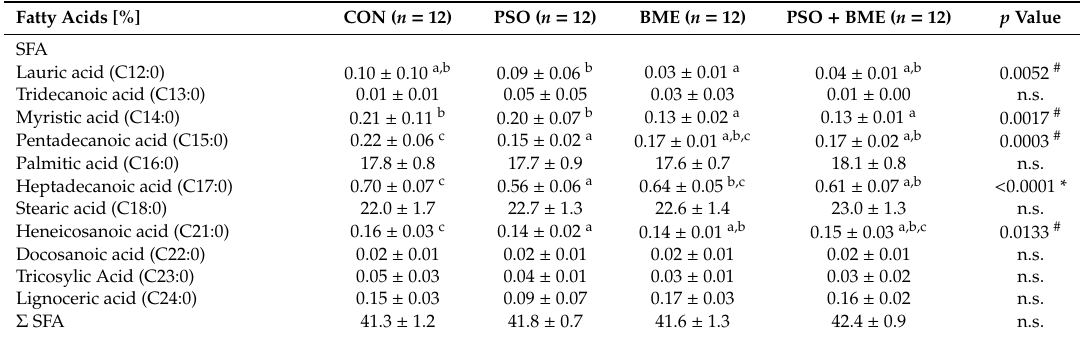
Figure 3. Exemplary GC-FID chromatogram of fatty acid profile in liver. Table 2. Fatty acids profile in liver of experimental groups.